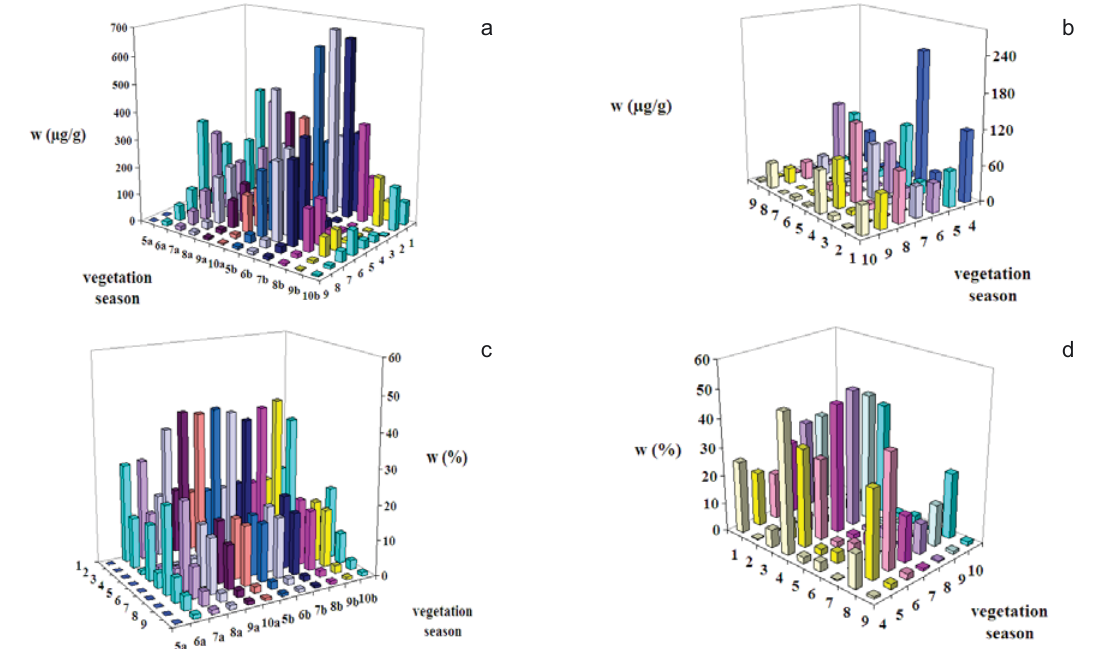
Figure 8. The effect of vegetation season on the amount (a,b) and representation (c,d) of terpenes in P. abies L. Karst . and J. regia L. Individual terpenes: 1 - (+)- a -pinene, 2 - (-)-camphene, 3 – sabinene, 4 - (-)- b -pinene, 5 – myrcene, 6 - R-(+)-limonene, 7 - (-)-bornylacetate, 8 - (-)- trans -caryophyllene, 9 - a -humulene, vegetation season: April – October, a - this-year needles, b - previous year